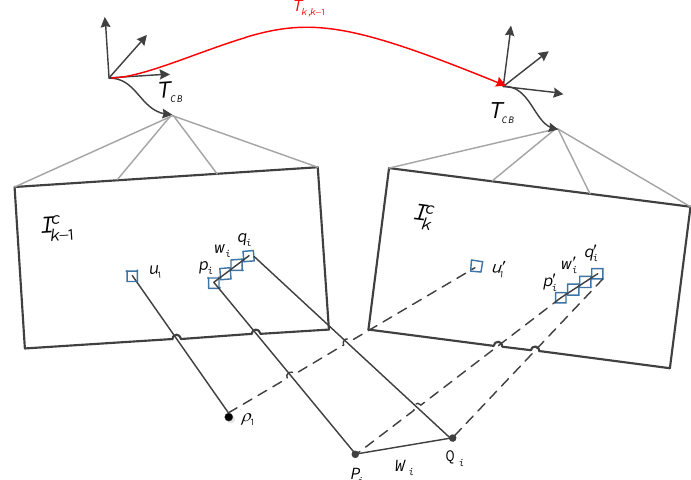
Figure 4. Relative pose between the current frame and the previous frame parameterizes the position of the reprojection point in the new image. Perform sparse image alignment to minimize luminosity error between image blocks corresponding to the same 3D point (blue block) to solve pose increment T kk − 1 . To facilitate the solution, we write the cost function in matrix